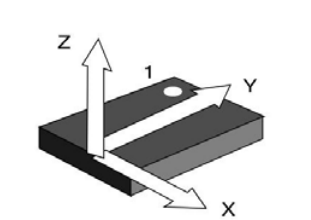
Figure 8. Diagrams illustrating the axes of 3-axis